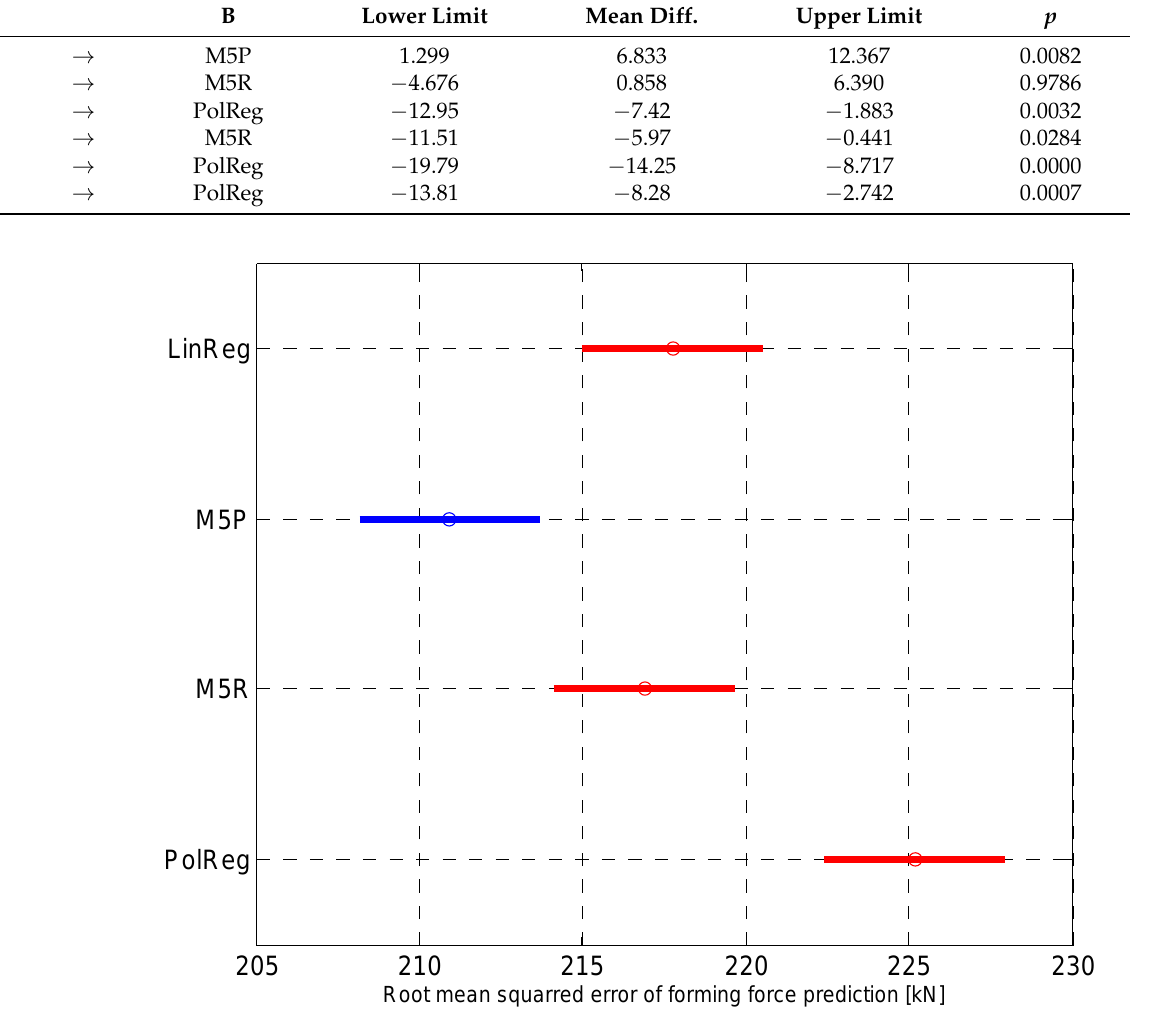
Figure 11. Chart to evaluate the different performance means. LinReg, M5R and PolReg differ significantly from M5P with the lowest